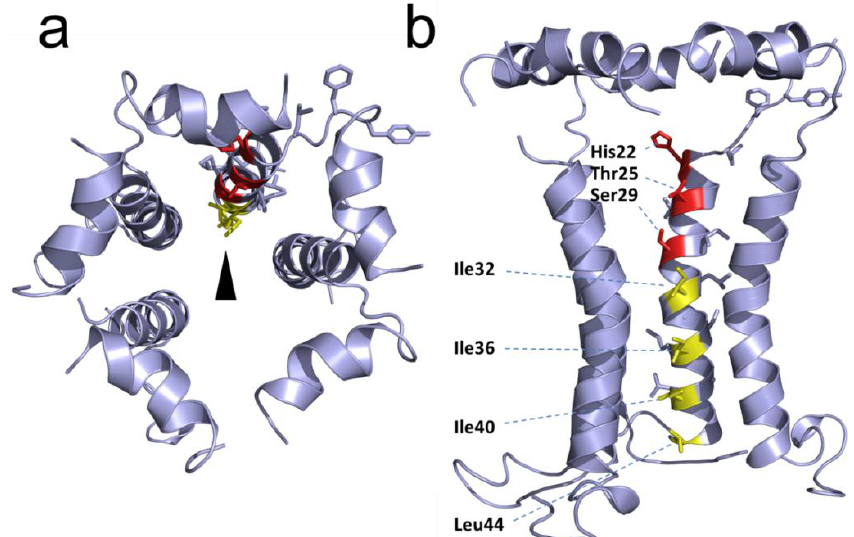
Figure 4. Structural model of RSV SH protein. Top view ( a ) and side view ( b ) of the SH protein pentamer [148]. In the latter, one monomer has been removed. The lumenally oriented polar residues (red) and hydrophobic residues (yellow) in the α-helical bundle are